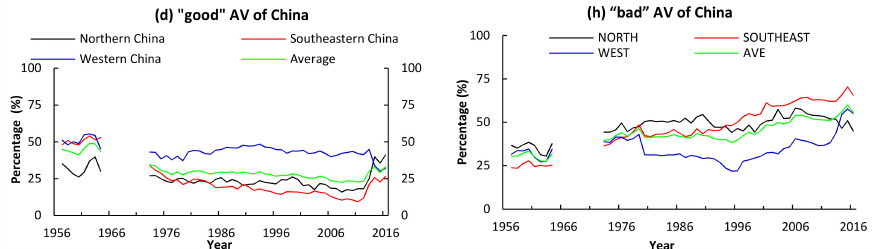
Figure 3. Annual percentages (%) of ‘bad’ visibility (<10 km, left column) and ‘good’ visibility ( ≥ 20 km, right column) in the PCCs of China during 1957–2016: ( a ) ‘good’ AV of northern China; ( b ) ‘good’ AV of southeastern China; ( c ) ‘good’ AV of western China; ( d ) the average percentage of ‘good’ AV of China; ( e ) ‘bad’ AV of northern China; ( f ) ‘bad’ AV of southeastern China; ( g ) ‘bad’ AV of western China; ( h ) the average percentage of ‘bad’ AV of China.